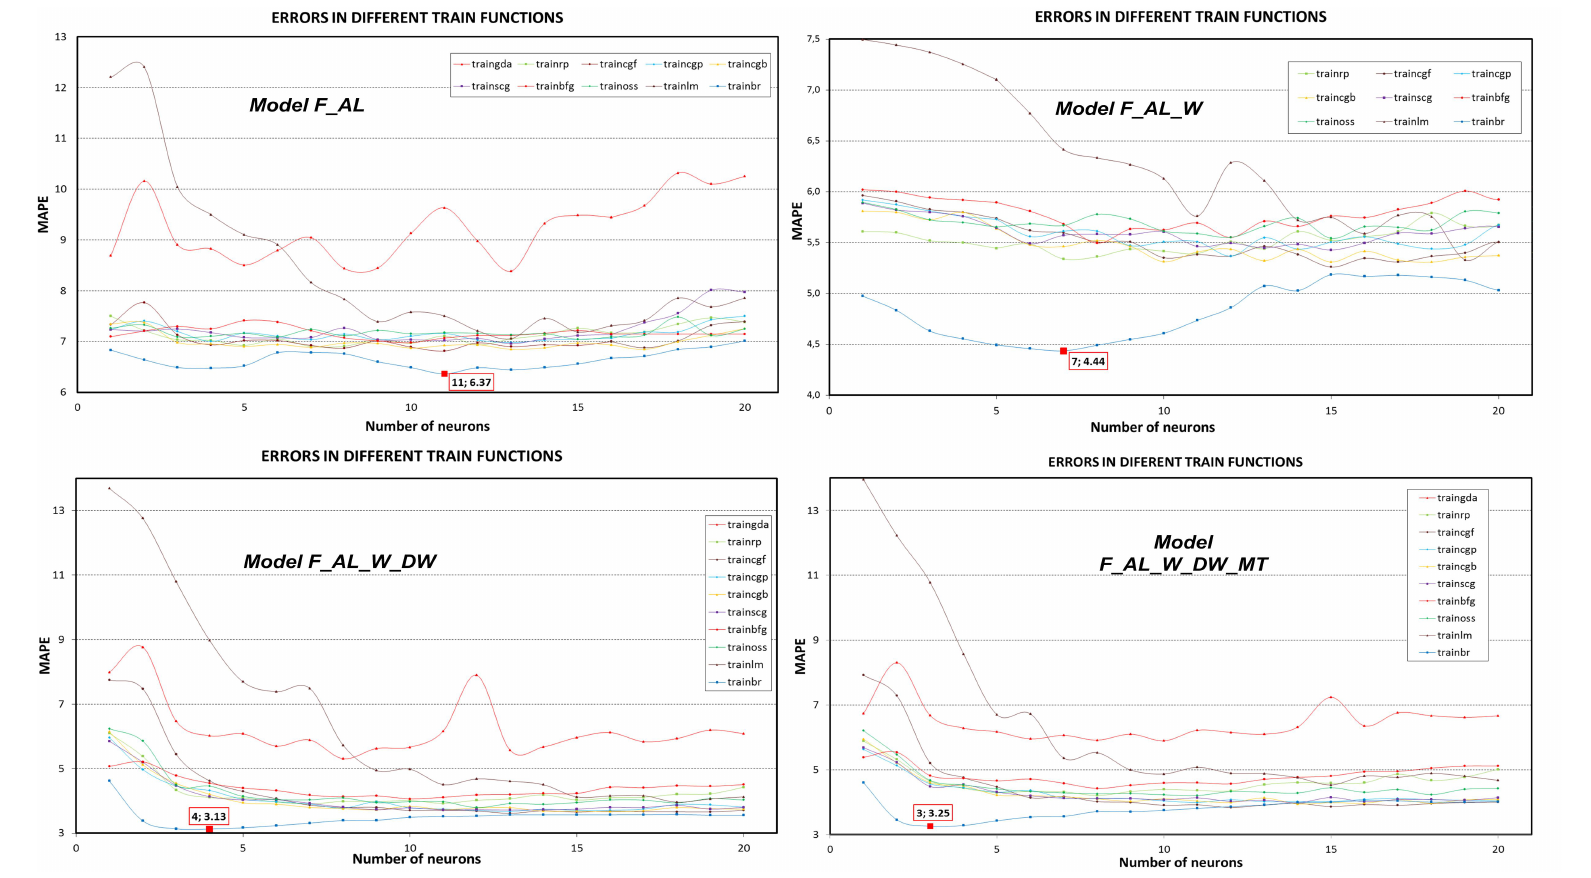
Figure 5. MAPE (%) in each of the models for the operation stage, considering all training functions and varying number of neurons. (Note: F_AL : Forecast with Aggregated Load; F_AL_W : Forecast with Aggregated Load and Workability; F_AL_W_DW : Forecast with Aggregated Load, Workability and Day of the Week; F_AL_W_DW_MT : Forecast with Aggregated Load, Workability, Day of the Week and Mean Temperature; F_AL_W_DW_RH : Forecast with Aggregated Load, Workability, Day of the Week and Relative Humidity; F_AL_W_DW_SR : Forecast with Aggregated Load, Workability, Day of the Week and Solar Radiation; F_AL_W_DW_allW : Forecast with Aggregated Load, Workability, Day of the Week and all